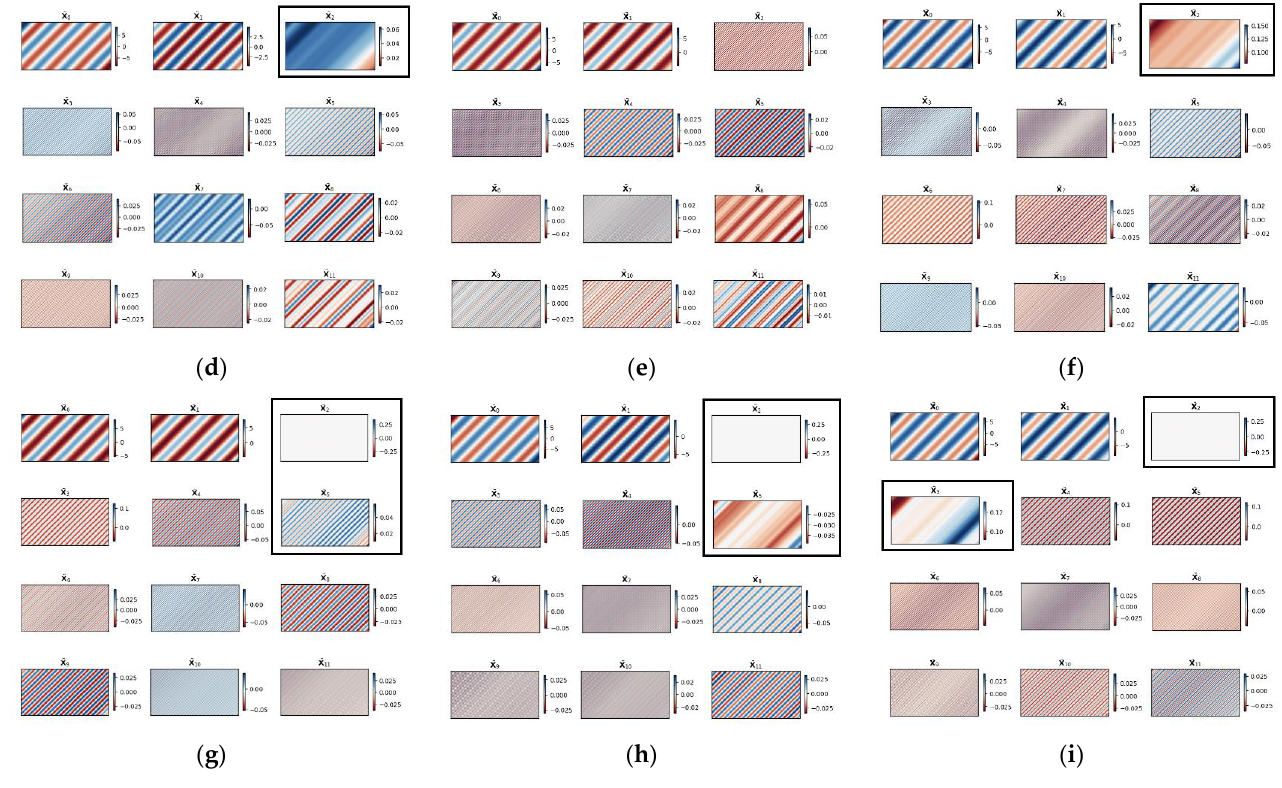
Figure 7. Comparison of the trajectory matrix decomposition of all signals in consideration: bearing without faults ( a – c ); the bearing with one spall ( d – f ); the bearing with three spalls ( g – i ); phase A ( a , d , g ); phase B ( b , e , h ); phase C ( c , f , i ).